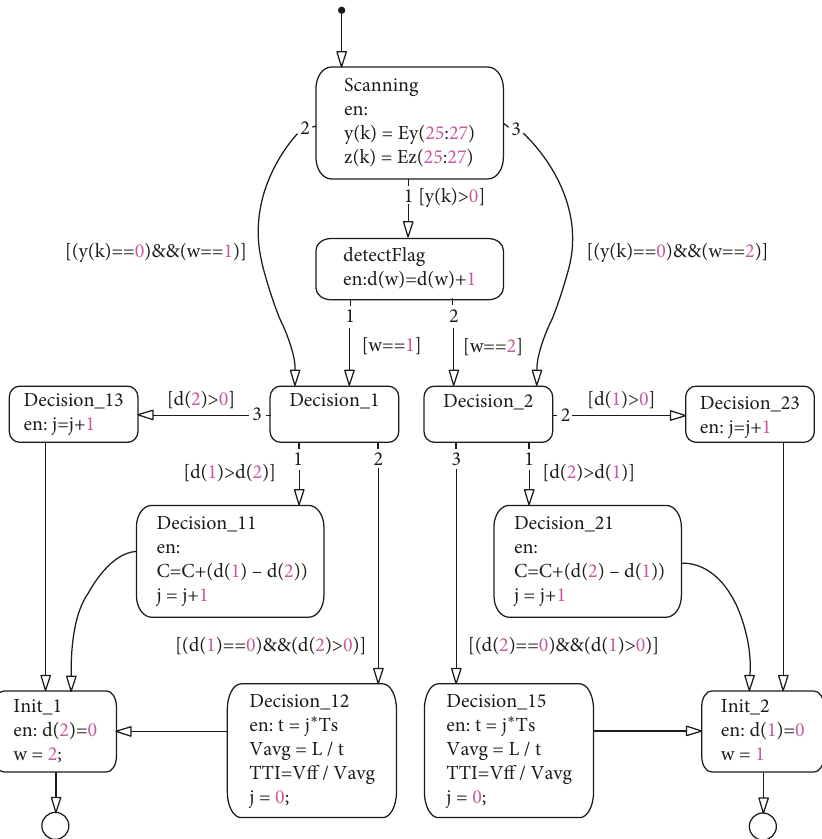
Figure 8: SDA finite state machine diagram for calculating vehicular count, speed, and